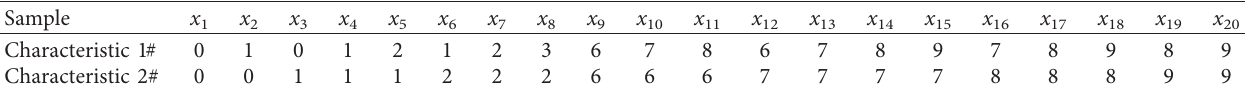
Figure 13: The effect of different damages differentiation (a) before and (b) after PCA. Table 3: Sample